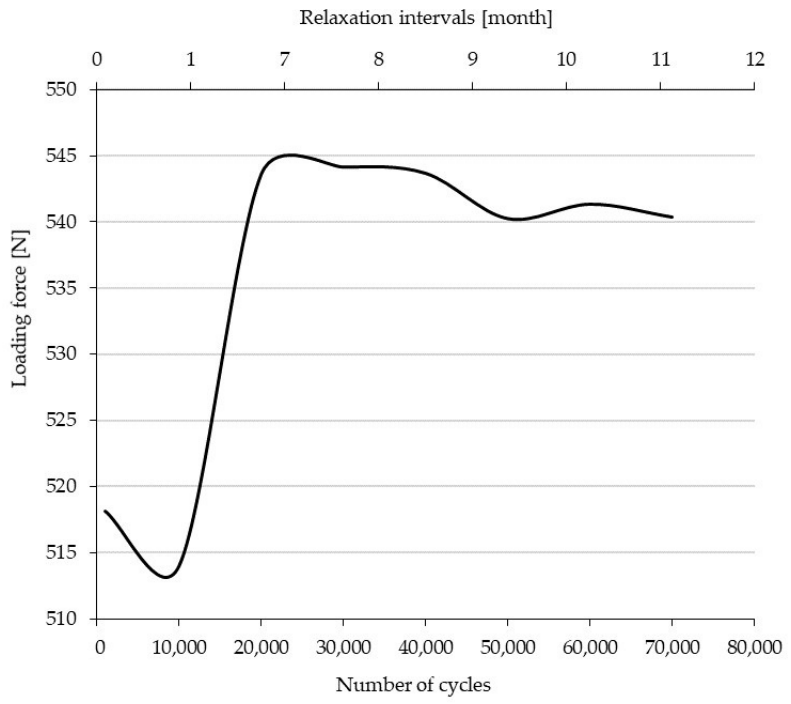
Figure 7. Loading force versus relaxation time in 60 mm ski bending in the interval 0–70,000 cy- cles.